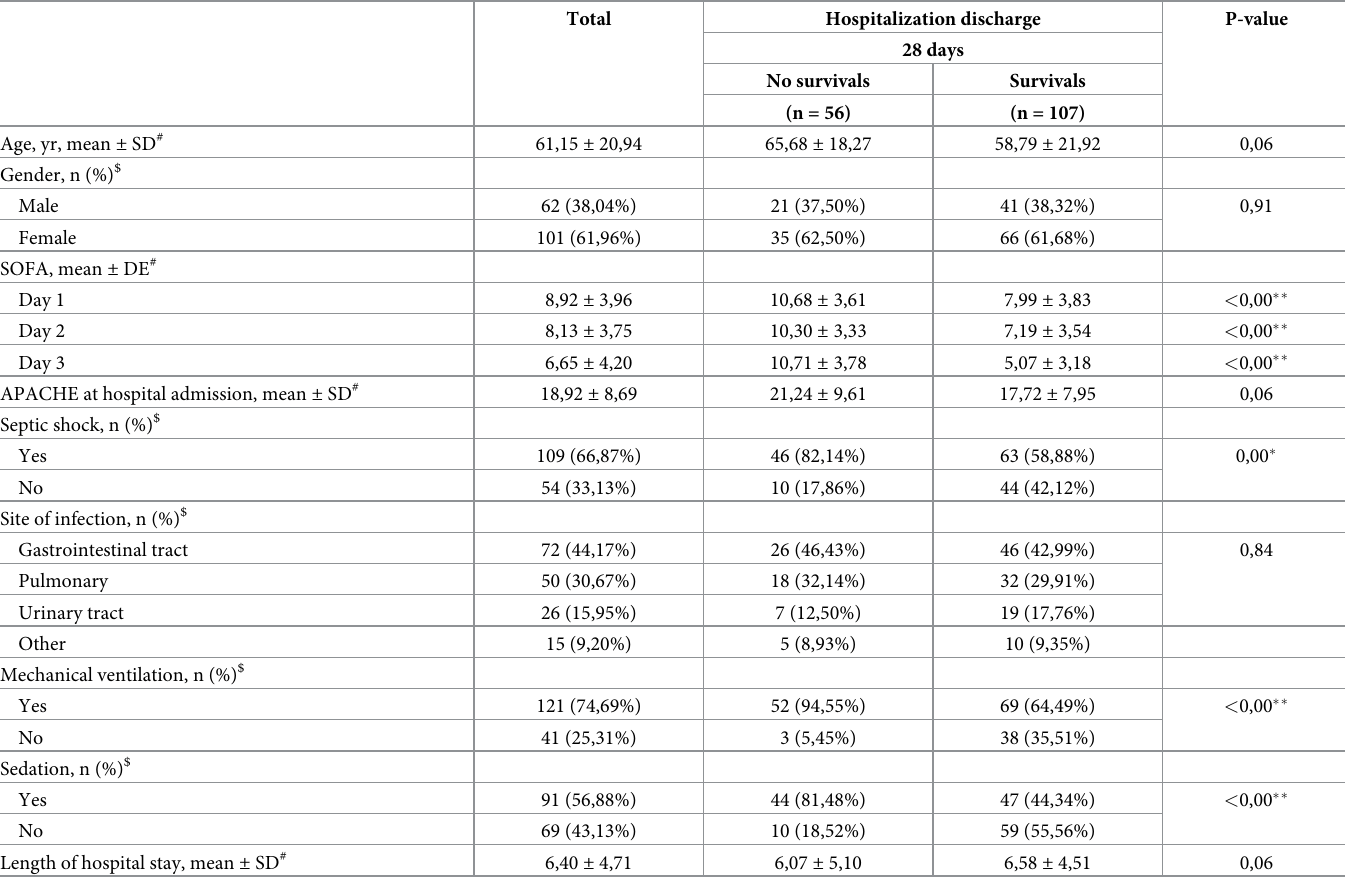
Table 1. Clinical characteristics of patients attended with sepsis at 28 days of hospitalization comparing the hospital discharge condition. Clinical